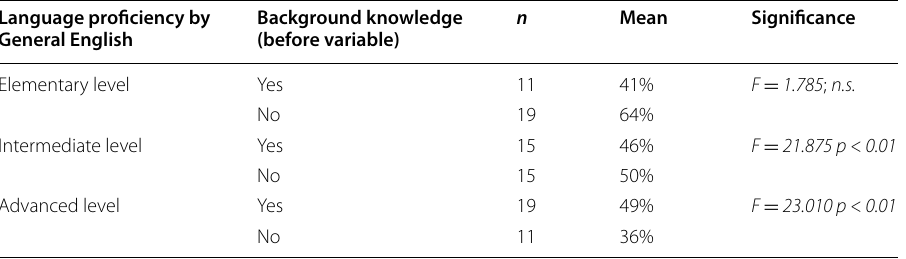
Table 8 Reading test (text 3) according to language proficiency (General English) and background knowledge: comparison of means